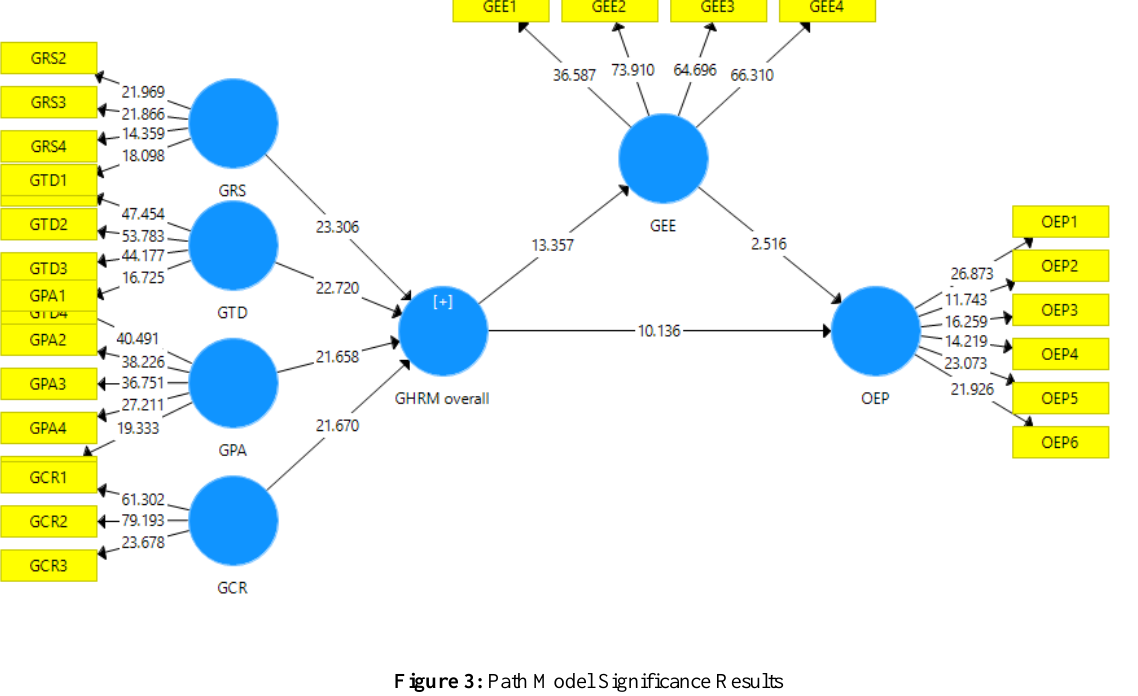
Figure 3: Path Model Significance